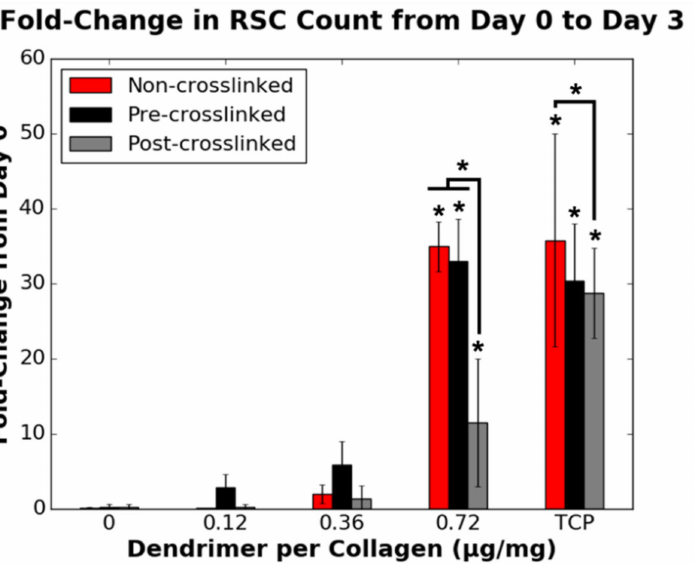
Figure 9. Effect of the quantity of IKVAV-capped dendrimers added to the various collagen substrates on the fold-change in RSC cell count from day 0 to day 3 ( n = 9). A fold-change of 1 is equivalent to no change in cell density. RSCs were seeded onto non-collagen coated wells (TCP controls) on the same 48-well plates as each collagen substrate variety. * denotes statistically significant difference ( p ≤ 0.001) between the data point annotated and the respective 0 µ g/mg value for each collagen substrate, unless indicated